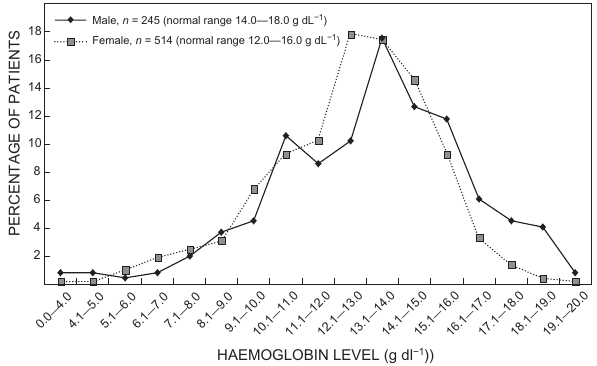
Figure 1: Distribution of haemoglobin levels of hospitalised geriatric patients ( n = 759)